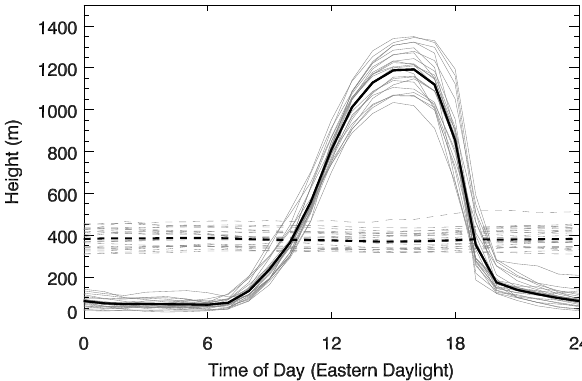
Fig. 6. Schematic showing the quasi steady-state distribution of